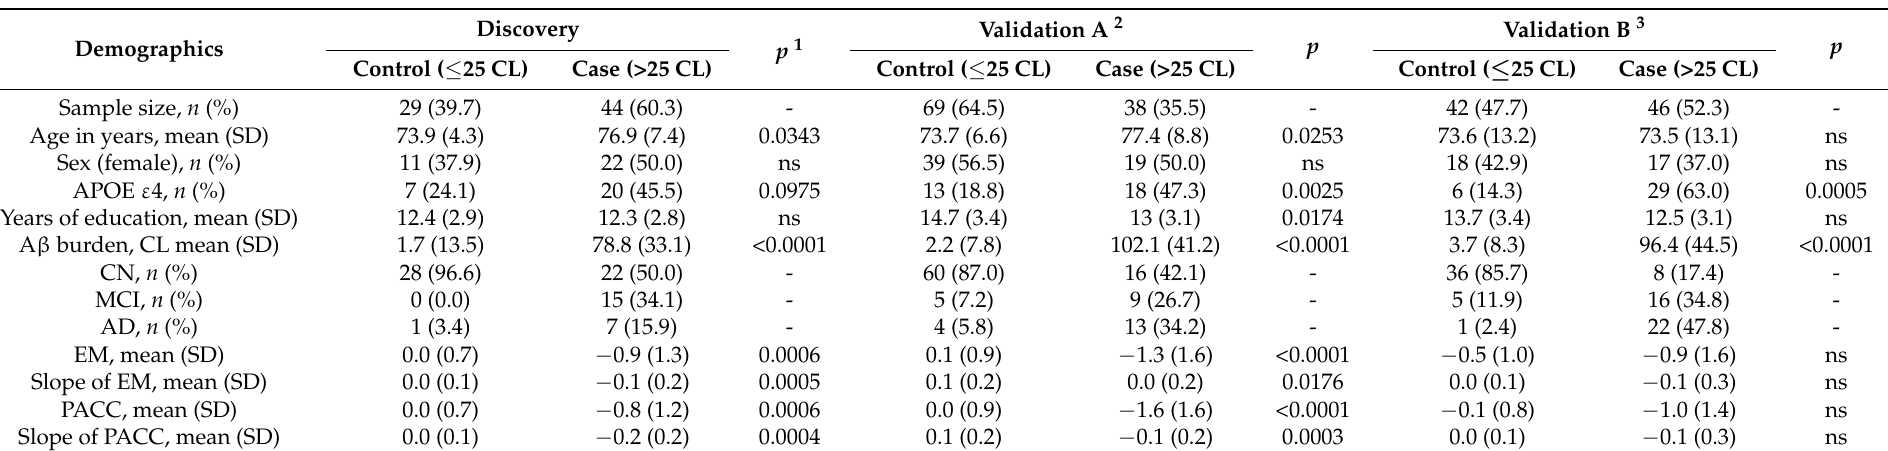
Table 1. Demographic characteristics of our